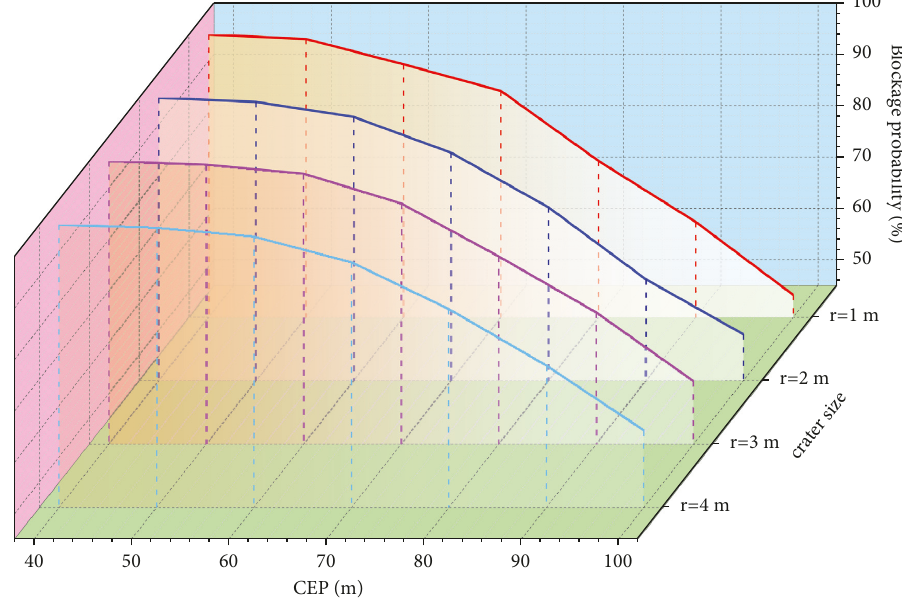
Figure 19: Influence of the CEP and crater size of subprojectiles on the blockage